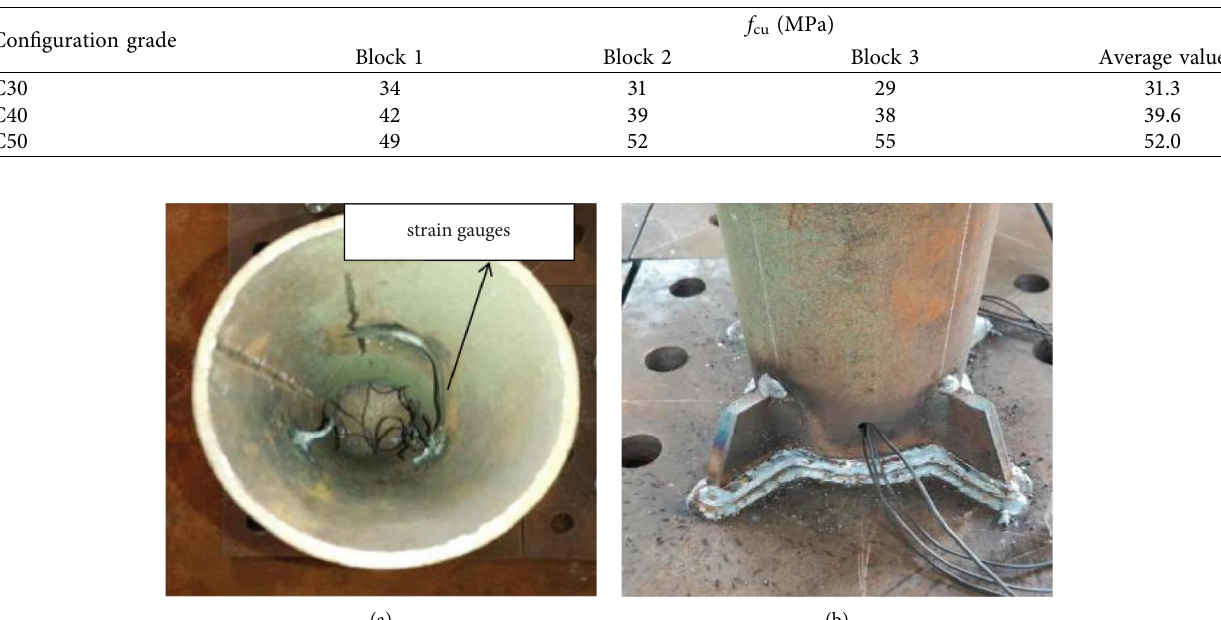
Figure 4: Sticking of strain gauges on inner wall: (a) arrangement of inner strain gauges and (b) wire handling method.